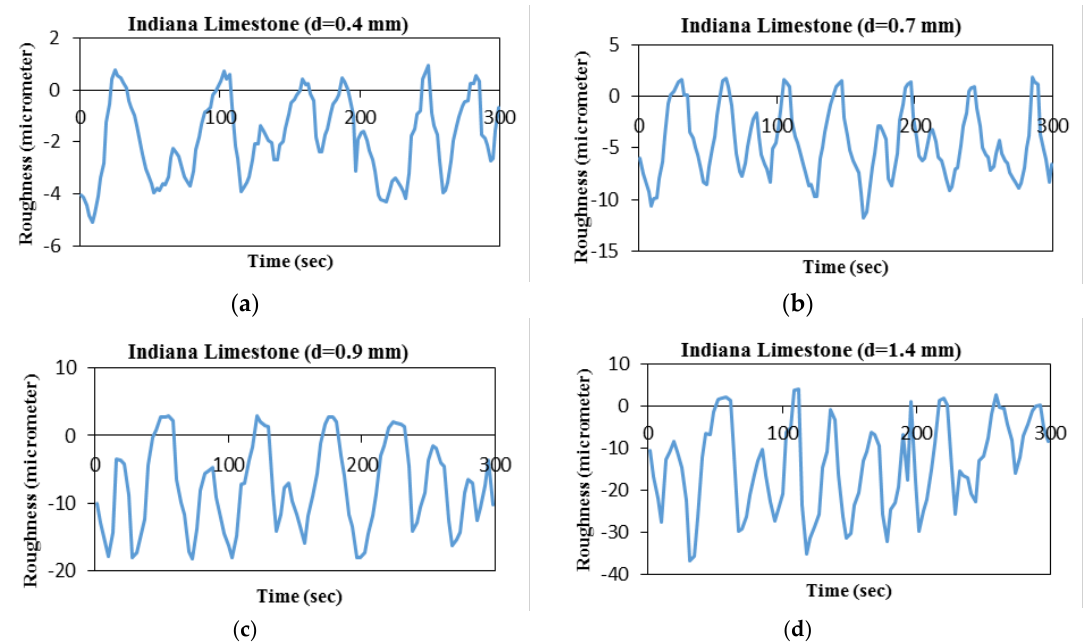
Figure 20. Variation of groove surfaces at various DOCs: ( a ) d = 0.4 mm; ( b ) d = 0.7 mm; ( c ) d = 0.9 mm; ( d ) d = 1.4